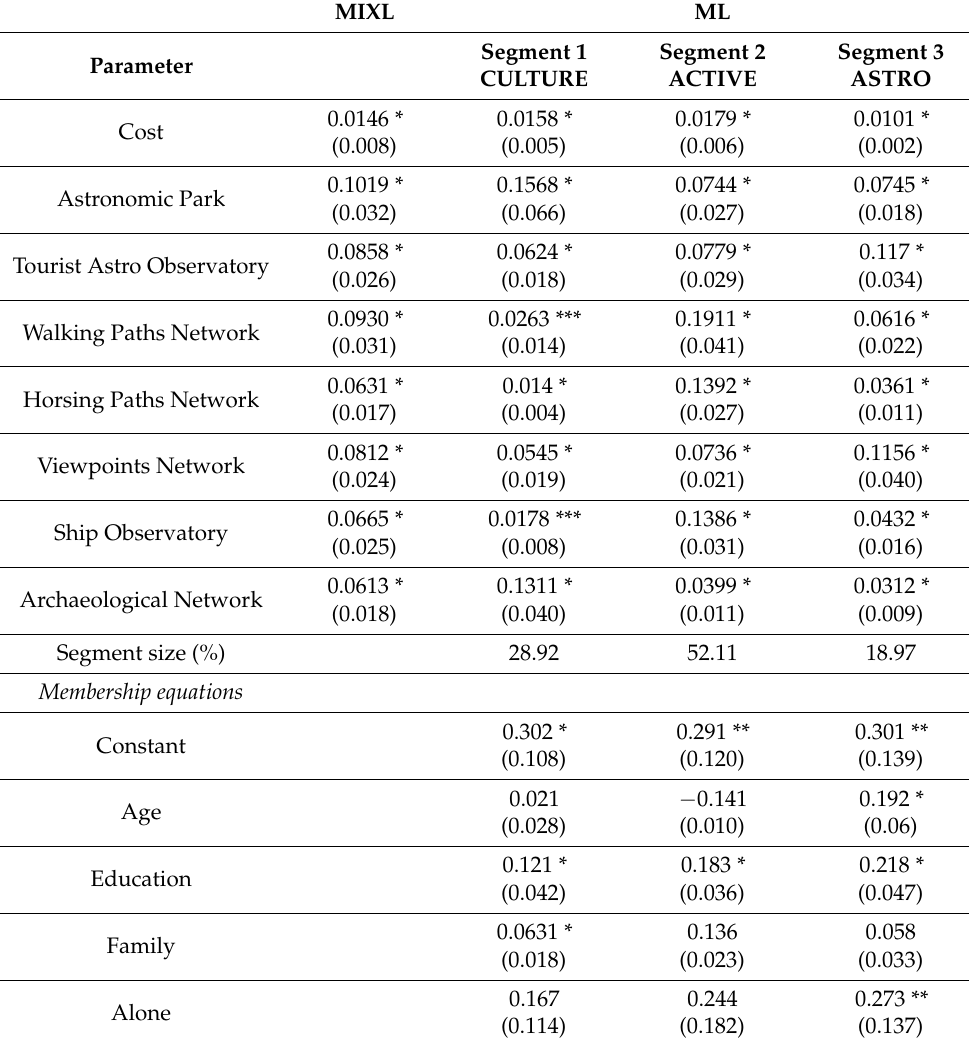
Table 3. Parameter estimates of the MIXL and LC DCE models (standard deviations in brackets). MIXL